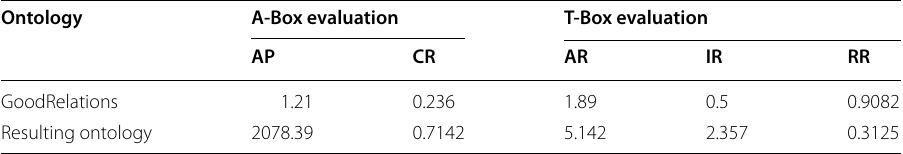
Table 9 The list of metrics for evaluating the resulting ontology Ontology A-Box evaluation T-Box evaluation AP GoodRelations Resulting